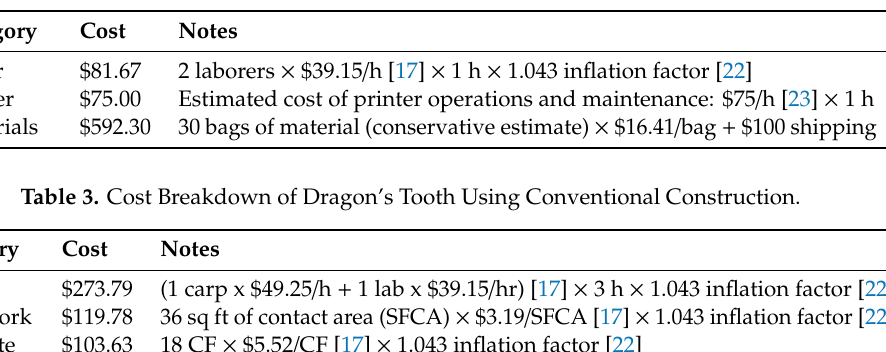
Table 2. Cost Breakdown of Dragon’s Tooth Using three-dimensionally (3D)-Printed Construction.